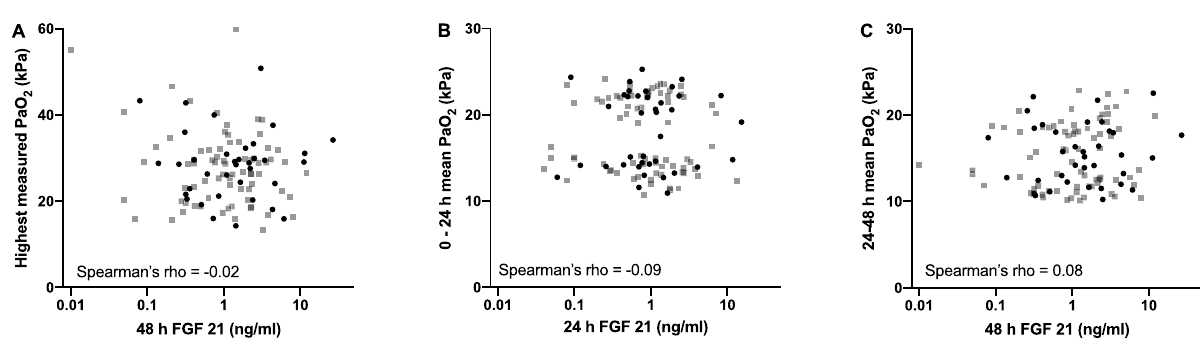
Figure 2. Concentrations of FGF 21 in relation to PaO 2 . ( A ) highest arterial blood PaO 2 value measured during the first 48 h of ICU stay and FGF 21 concentration measured at 48 h. ( B ) time-weighted mean arterial blood PaO 2 from admission to 24 h and FGF 21 concentration measured at 24 h. ( C ) time-weighted mean arterial blood PaO 2 from 24 to 48 h and FGF 21 concentration measured at 48 h. Black circles, poor outcome; grey squares, good outcome.